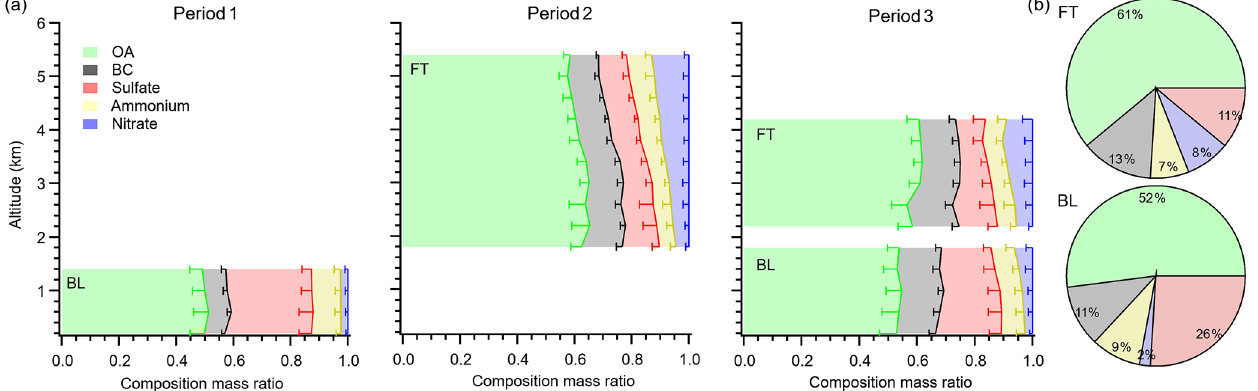
Figure 3. (a) The average vertical distribution of PM 1 chemical composition ratios in the BB-polluted FT and BL separately in each period. The width of colour bars represents the average mass ratio of different species in every 400m bin. The error bars represent 1 standard deviation. (b) Pie charts showing campaign-average chemical composition ratios in the BB-polluted FT and BL